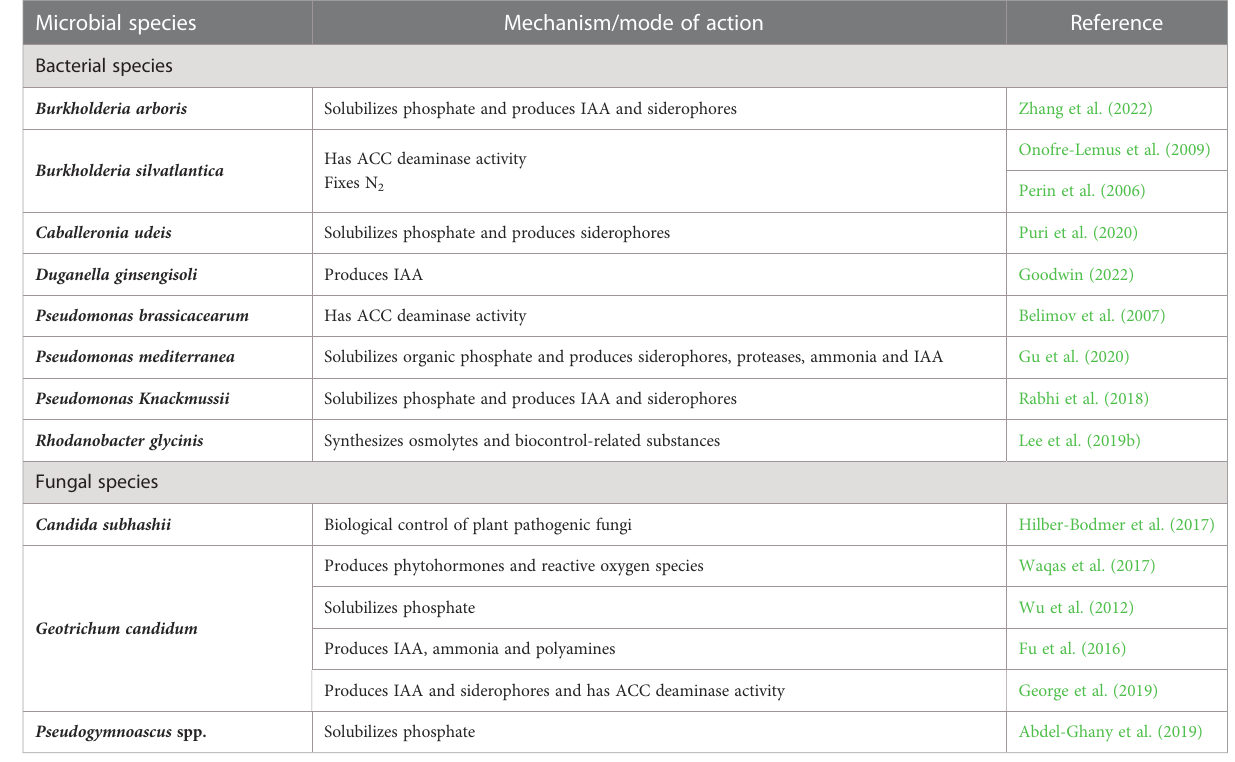
TABLE 4 List of microbial species whose populations are enriched by the soil application of fungal CFs and DEs used by Baroja-Ferna ́ ndez et al. (2021). Microbial